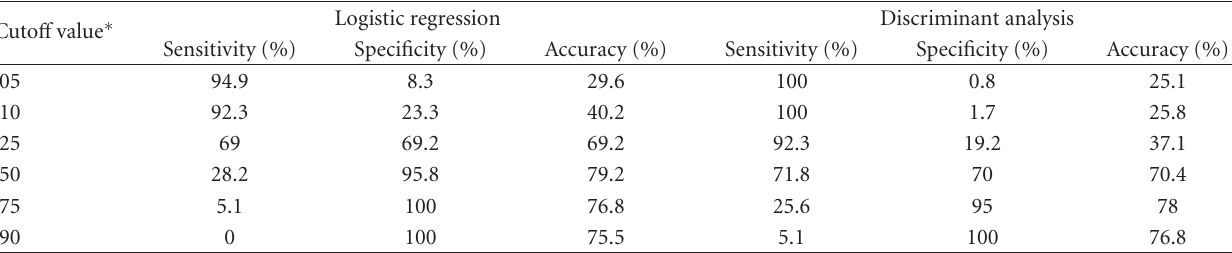
Table 2: Sensitivity and specificity of logistic regression and discriminant analysis models, at various cuto ff points for the probability of having any asthma